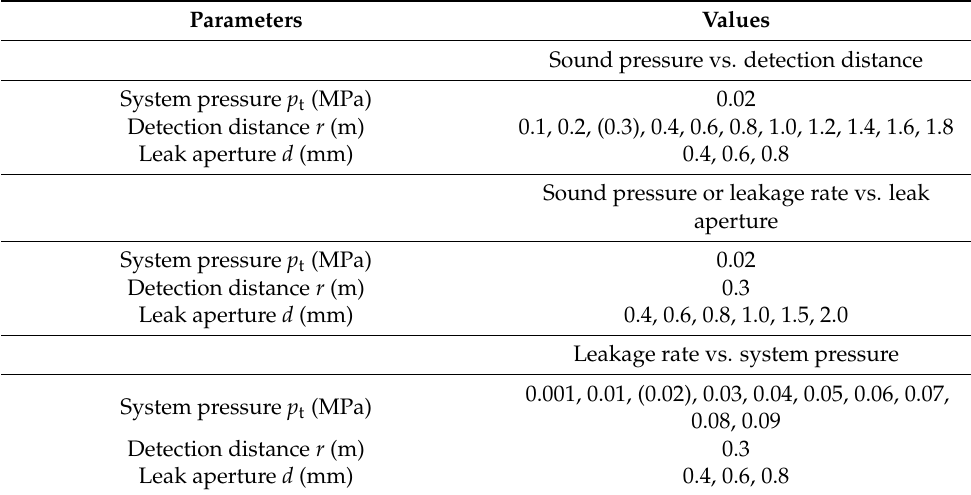
Table 1. Parameter settings for the different